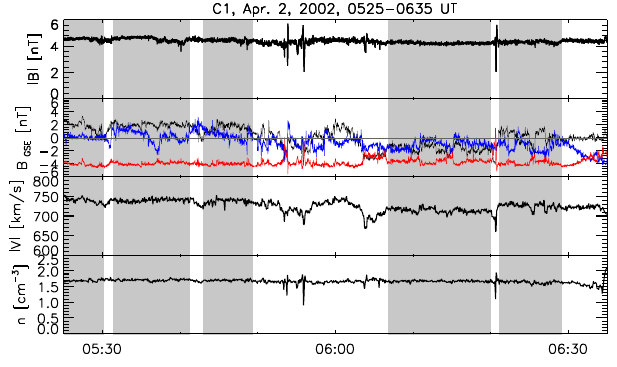
Fig. 1. Time-series data of the fast solar wind event measured by Cluster-1: magnetic field magnitude | B | and components in GSE Figure 1: Time series data of the fast solar wind event measured by Cluster-1: Magnetic (cid:28)eld coordinates: B x (black), B y (blue), and B z (red) in the two top pan- magnitude j B j and components in GSE coordinates: B x (black), B y (blue), and B z (red) in the els, ion bulk velocity | V SW | in the middle and ion number density two top panels, ion bulk velocity j V SW j in the middle and ion number density n i in the bottom n i in the bottom panel. The gray shaded time intervals are used for panel. The gray shaded time intervals are used for the analysis. the